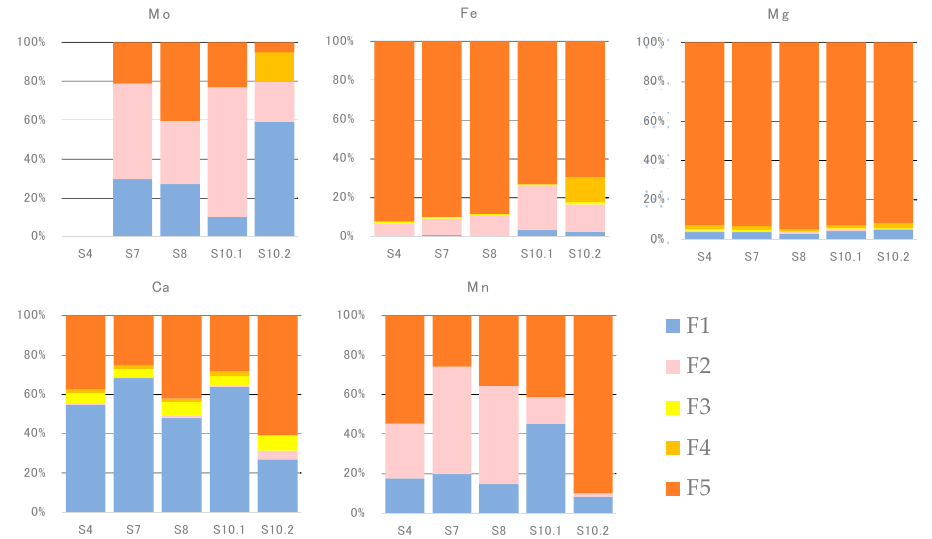
Figure A1. XRD patterns of the rivers (S4, Erdenet River; S7, Gavil River; and S8, Khangal River) and ponds (S10.1 and S10.2) sediment samples: Chl, chlorite; Mica, mica minerals; Am, amphibole; Cal, calcite; Qz, quartz; and F, feldspar.